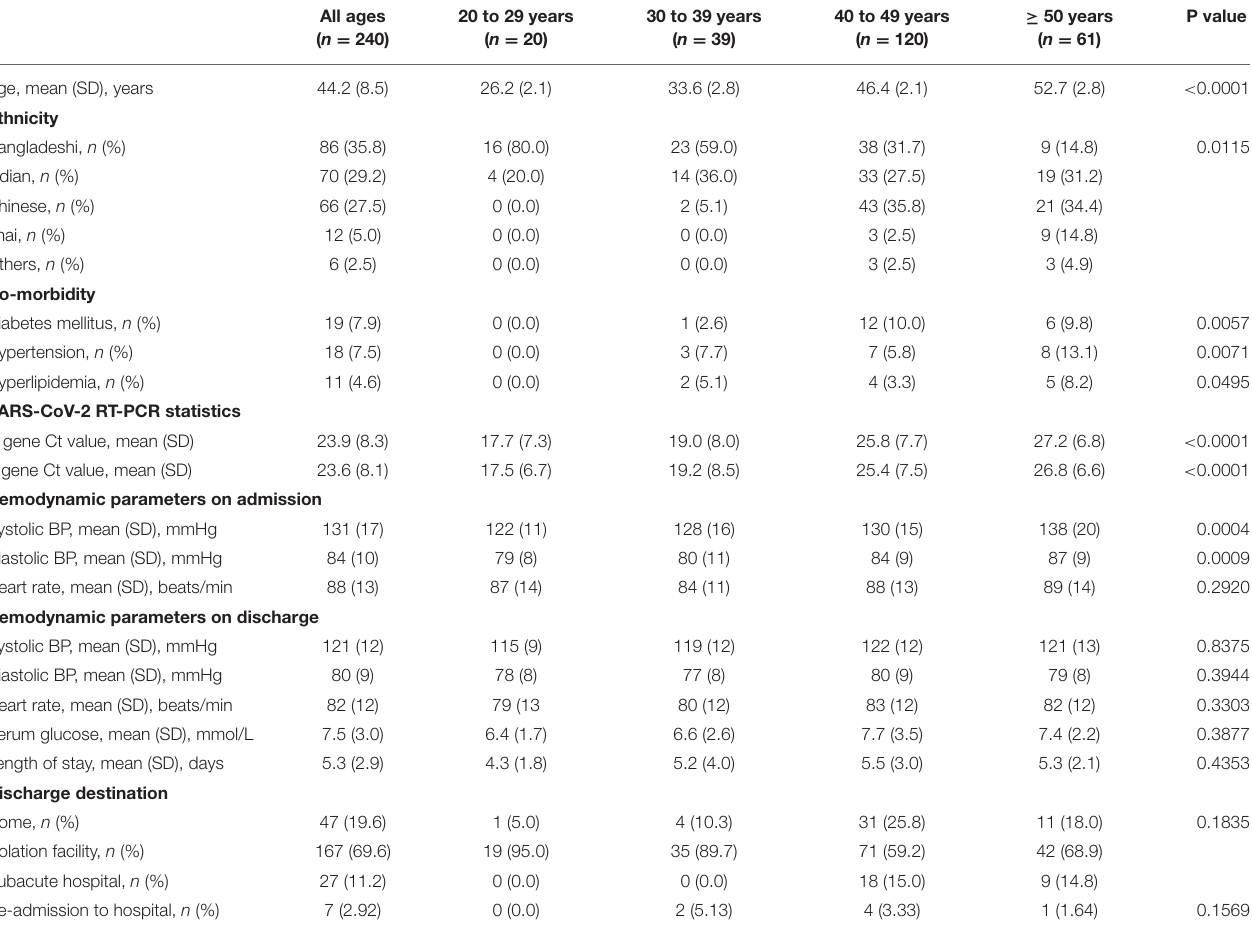
TABLE 1 | Demographics and clinical characteristics, stratified by